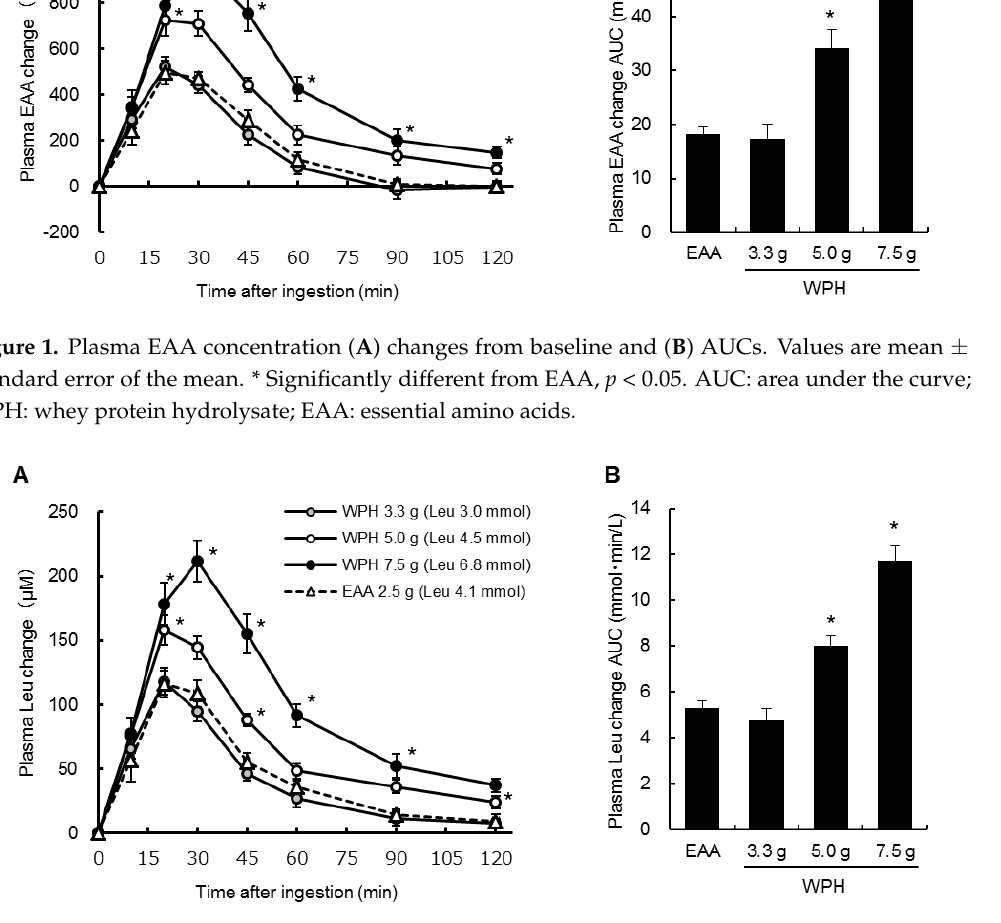
Figure 2. Plasma leucine concentration ( A ) changes from baseline and ( B ) AUCs. Values are mean ± standard error of the mean. * Significantly different from EAA, p < 0.05. Leu: leucine; AUC: area under the curve; WPH: whey protein hydrolysate; EAA: essential amino